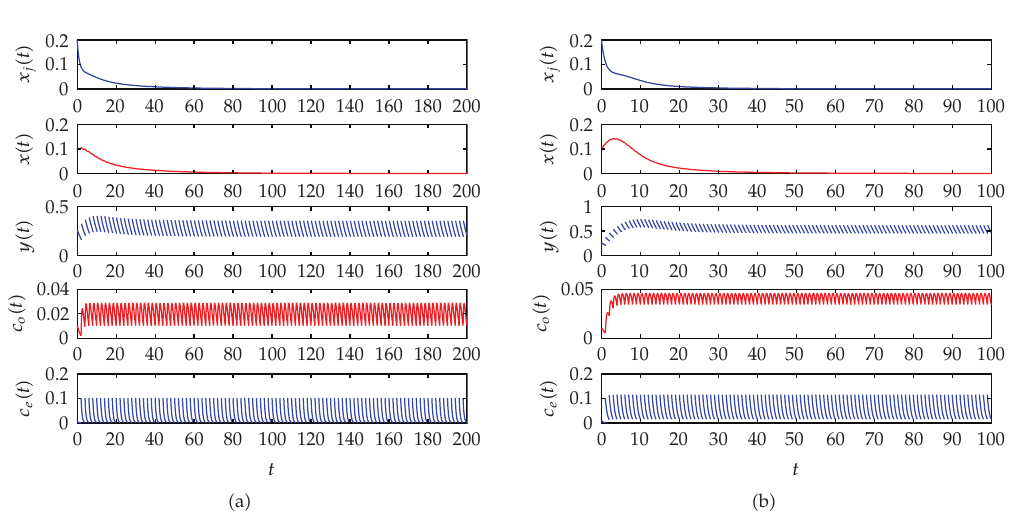
Figure 7: Dynamical behavior (cid:6) extinction (cid:7) of system (cid:6) 2.1 (cid:7) with a (cid:8) 0 . 8, b 1 (cid:8) 0 . 9, f (cid:8) 0 . 2, β (cid:8) 0 . 9, η (cid:8) 1, r (cid:8) 0 . 7 , b 2 (cid:8) 0 . 3, λ (cid:8) 0 . 9, k (cid:8) 1, g (cid:8) 0 . 5, m (cid:8) 0 . 7, h (cid:8) 2, l (cid:8) 0 . 1, and μ 2 (cid:8) 0 . 1, initial values x j (cid:6) 0 (cid:7) (cid:8) 0 . 2, x (cid:6) 0 (cid:7) (cid:8) 0 . 1, y (cid:6) 0 (cid:7) (cid:8) 0 . 1, c o (cid:6) t (cid:7) (cid:8) 0 . 01, and c e (cid:6) t (cid:7) (cid:8) 0 . 01. (cid:6) a (cid:7) Time series of system (cid:6) 2.1 (cid:7) with τ (cid:8) 1 . 5, T (cid:8) 2, μ 1 (cid:8) 0 . 16. (cid:6) b (cid:7) Time series of system (cid:6) 2.1 (cid:7) with τ (cid:8) 0 . 7, T (cid:8) 1, and μ 1 (cid:8) 0 .